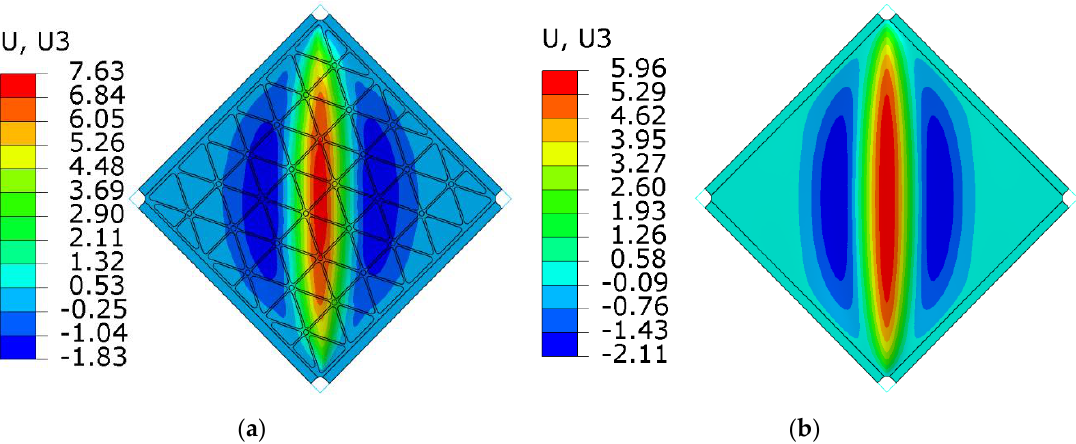
Figure 24. Deflection fields (mm) obtained from FEM analyses at the level of a maximum load equal to 103 N/mm: ( a ) stiffened plate, ( b ) smooth plate.